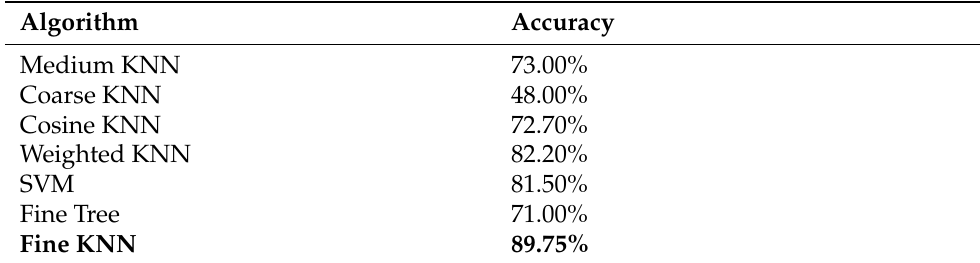
Table 5. Classifiers testing on Skeleton